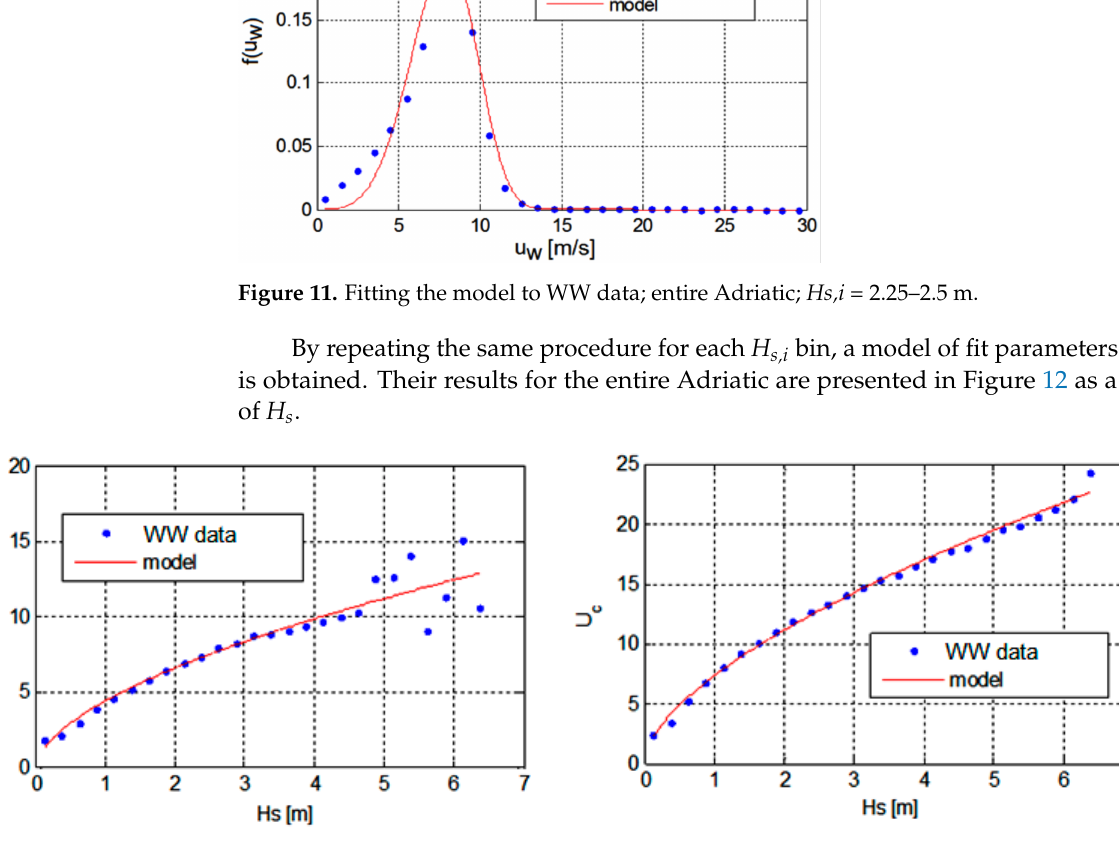
Figure 12. Distribution of k and Uc for Adriatic as a whole.